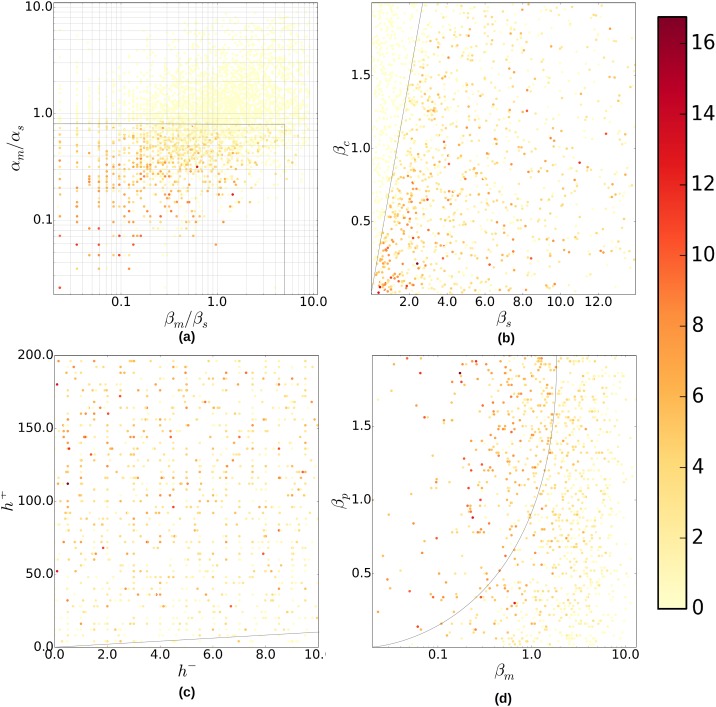
Parameter dependence found by random parameter sampling.The color gradient shows the magnitude of the protein peak fold-increase R. In Fig (a), the results are projected onto αm/αs vs. βm/βs on a log-log scale. In (b) the simulation results that fall within the subregion αm/αs < 0.8 and βm/βs < 4 (marked by lines in Fig (a)) are projected onto βc vs. βs. In (c,d) the parameter sets are further restricted to the subregion αm/αs > 0.8, βm/βs > 4 and βc/βs < 2/3 (marked by a dark line in Fig (b)) and the results are projected onto h+ vs. h− in Fig (c), and βp vs. βm in Fig (d), respectively. The color scale values are taken to be log1.4R for ease of viewing. Dark lines mark the rough division between the region with more high peaks and the region with fewer. In (c) and (d) the dark lines mark h+ = h− and βp = βm respectively.